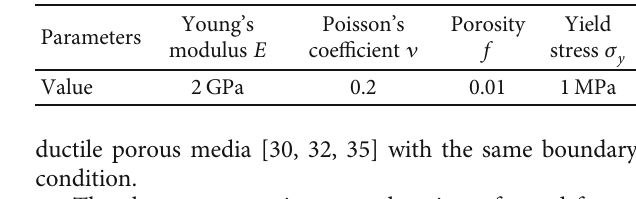
Figure 8: Cyclic strain-stress curve ( ε at r = a , θ = π /2 under shakedown limit load T 3 = 0 : 44 for porosity f = 0 : 01 with the following parameters of the solid matrix ν = 0 : 2 and ϕ = 20 ° . Table 1: Parameters of the material in numerical simulations.